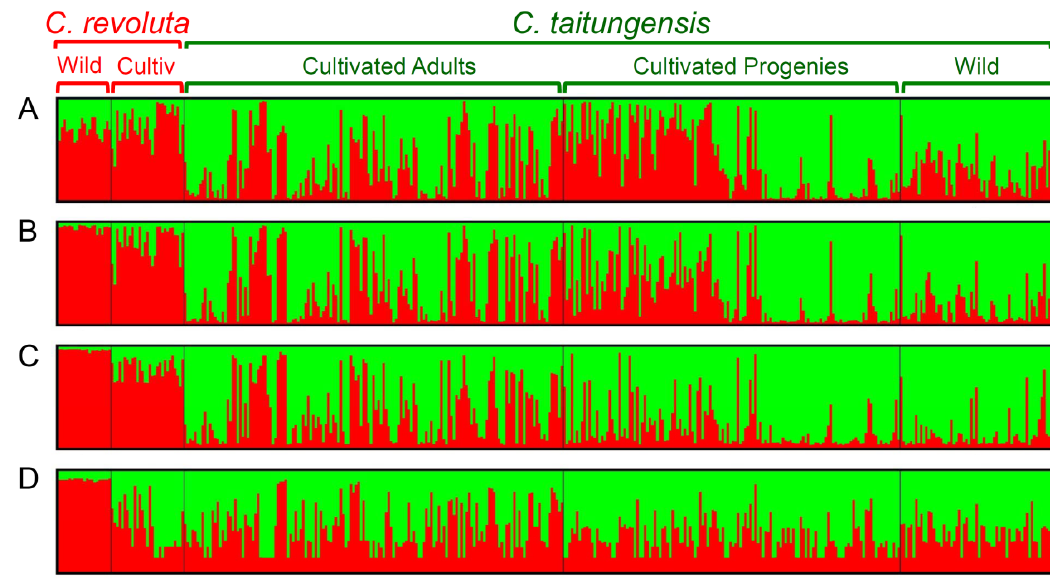
Figure 3. Assignment test by Bayesian clustering analysis of wild populations and cultivated samples of C. revoluta and C. taitungensis at clustering number K = 2. Patterns of genetic composition of each individual are detected by ( A ) 262 neutral loci; ( B ) species-associated loci at criteria LOD 3.0; and ( C ) LOD 6.0; and ( D ) the loci of linkage subgroup 1 of LOD 6.0.